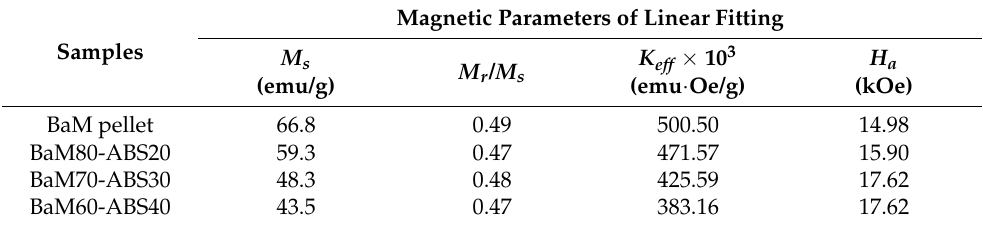
Table 2. Magnetic parameters of pressed BaM pellet and BaM-ABS composites from the linear fitting according to the law of approach to saturation.